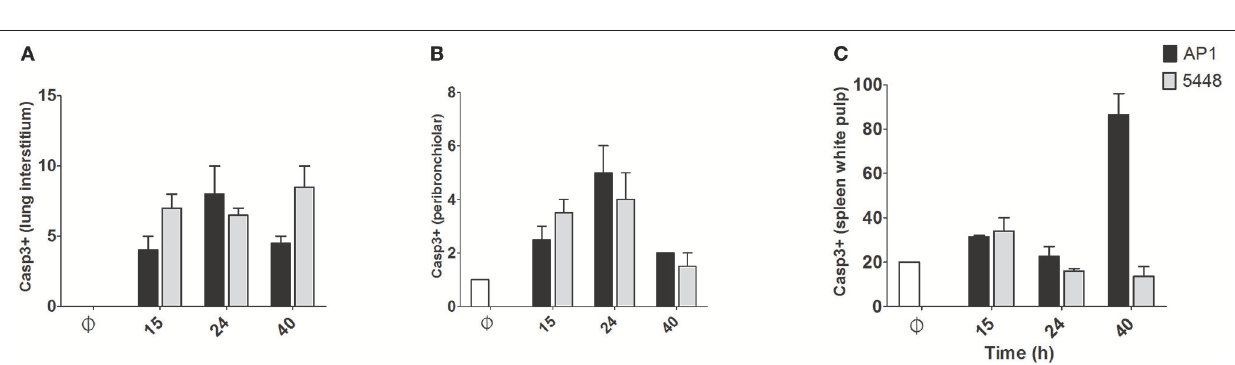
FIGURE 3 | Quantitative determination of apoptosis in lung and spleen. Apoptotic cells were identified by immunostaining for cleaved Casp3. Only cells with dark staining involving the nucleus were counted as positive. In A-C the y-axis shows the average number of cleaved Casp3 + cells per 10 high-power (400x magnification) fields. (A) Lung (interstitium). (B) Lung (peribronchiolar space). (C) Spleen (white pulp). Graphs represent mean values obtained from the two mice per group that were used for histological examination.